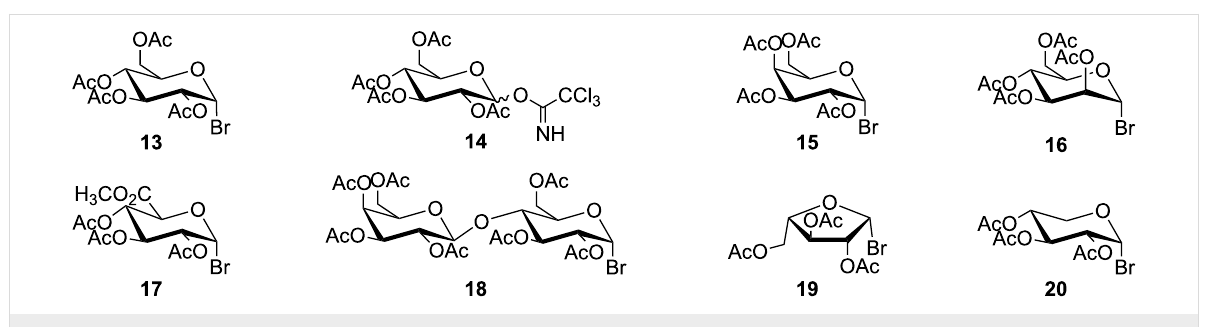
Figure 2: Synthesized glycosyl